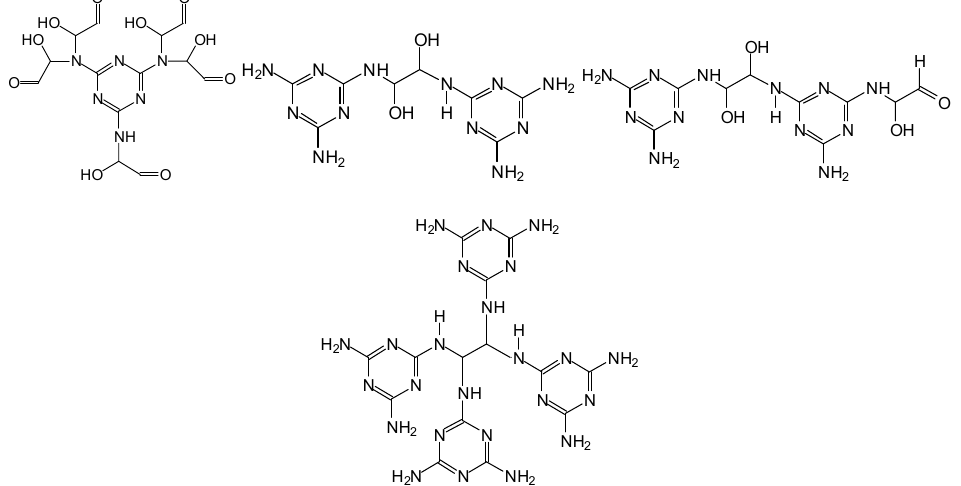
Peak Chemical species